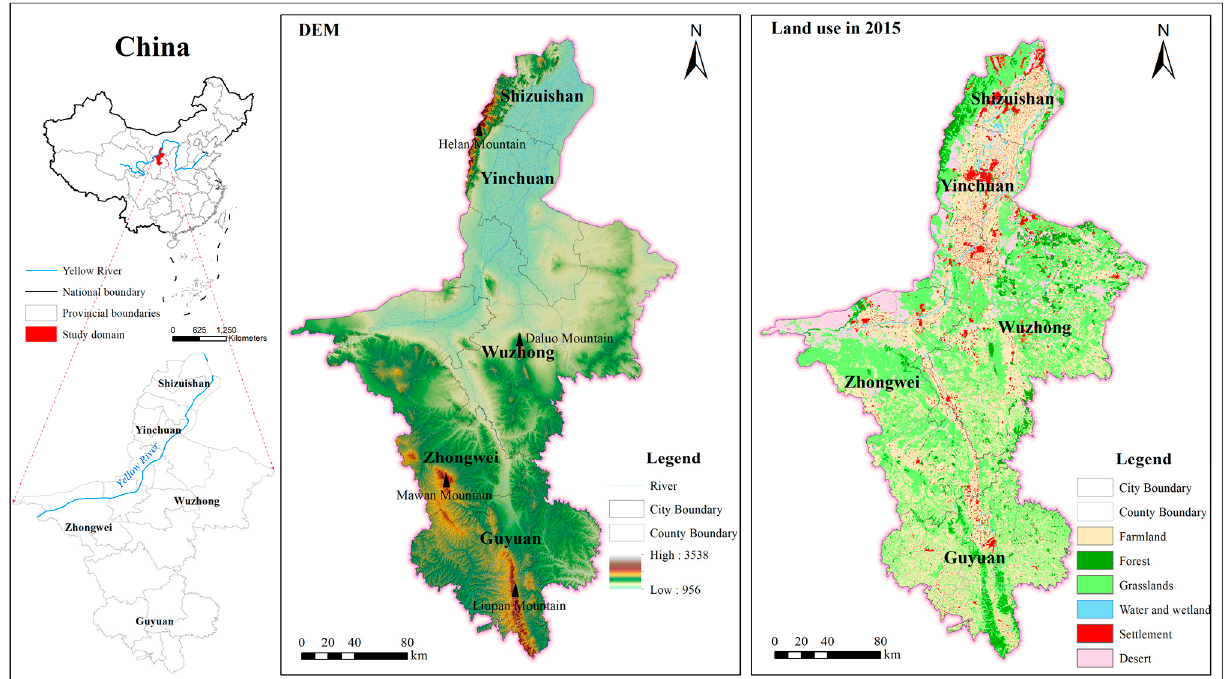
Figure 1. Geographical location of the study area.